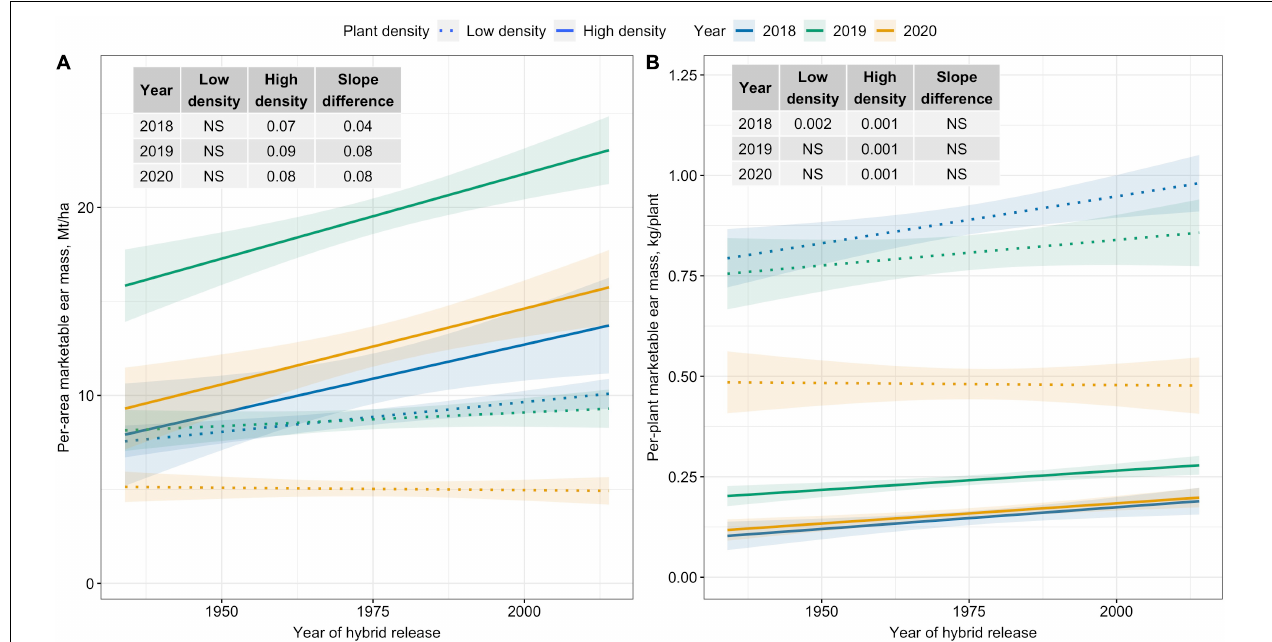
FIGURE 1 | Best fit line for relationship between year of hybrid release and (A) per-area marketable ear mass (Mt/ha), and (B) per-plant marketable ear mass (kg/plant) for two levels of plant density at Urbana, IL in 2018–2020. Ninety-five percent confidence intervals are shown by the shaded regions around the line of best fit. Slope estimates from linear regression analysis for Low plant density (9,900 plants/ha), High plant density (79,000 plants/ha), and difference between two plant densities are shown. Non-significant slope estimates are denoted by NS ( α = 0 . 05).